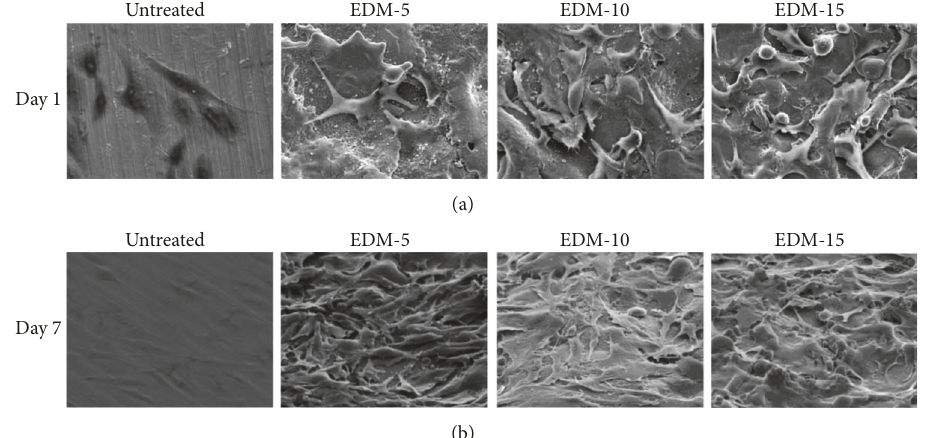
Figure 21: SEM micrograph of the in vitro MG-63 cells attachment and proliferation on the treated and untreated samples for (a) day 1 and (b) day 7